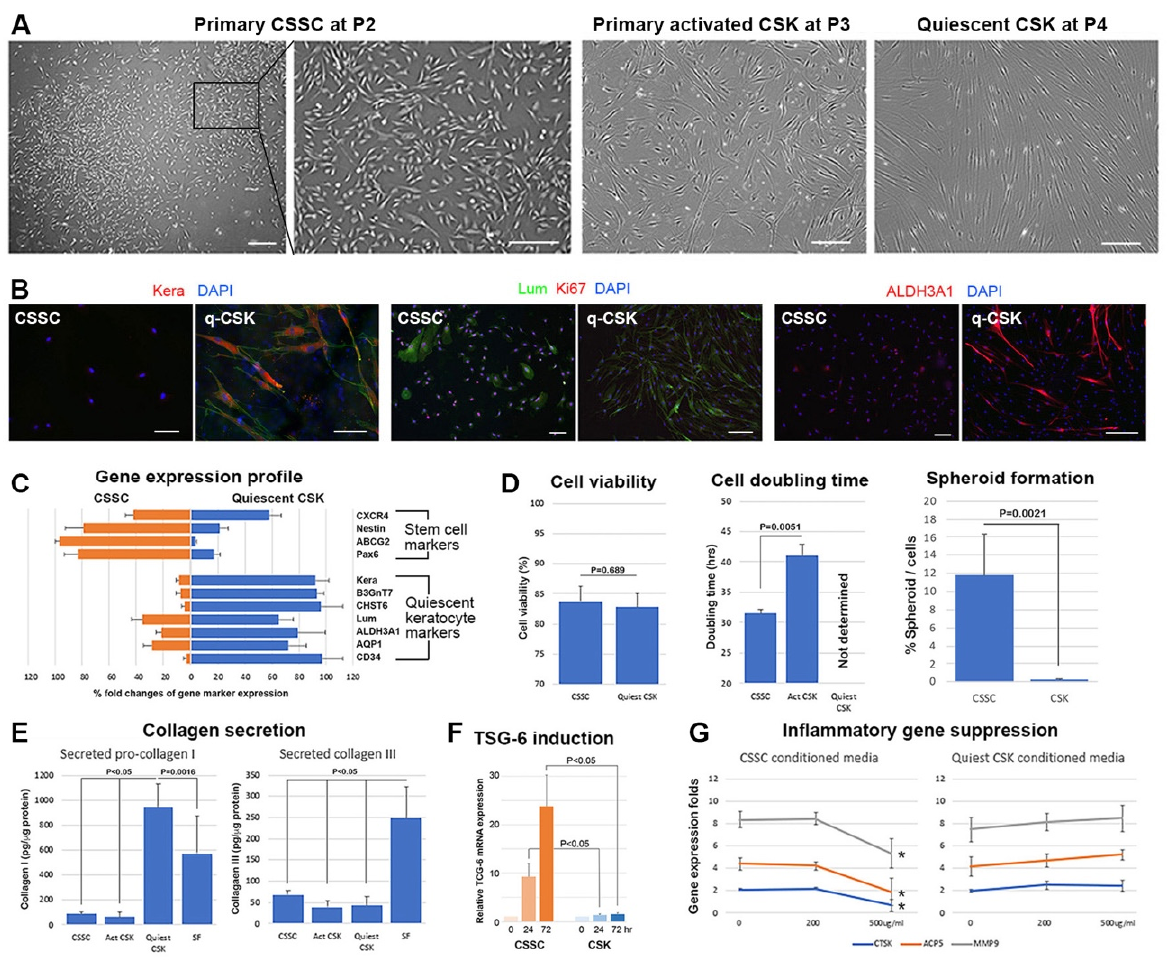
Figure 2. Characterization of CSSC and CSK. ( A ) Phase contrast images of the primary cell culture; scale bars: 100 µ m. ( B ) Immunofluorescence of keratocan (Kera), lumican (Lum), aldehyde dehydrogenase 3A1 (ALDH3A1), and Ki67 for CSSC and CSK; scale bars: 50 µ m. ( C ) Gene expression profile of stem cell and corneal stromal markers by qPCR analysis. ( D ) Culture characterization: viability, doubling time, and spheroid formation (one-way ANOVA test). ( E ) Expression of collagen 1 and III in culture media (Mann–Whitney U test). ( F ) Expression of TSG-6 in cell cultures treated with TNF α . Time-dependent upregulation of TSG-6 in CSSC cultures, but not in CSK culture (one-way ANOVA test). ( G ) Osteoclast gene expression ( ACP5 , MMP9 and CTSK ) of mouse RAW cells induced by RANKL and ConA treatment and a dose-dependent suppression by CSSC conditional media (CM) concentrates (* p < 0.05, compared to non-CM treated control). No inhibition effect was observed for CSK CM